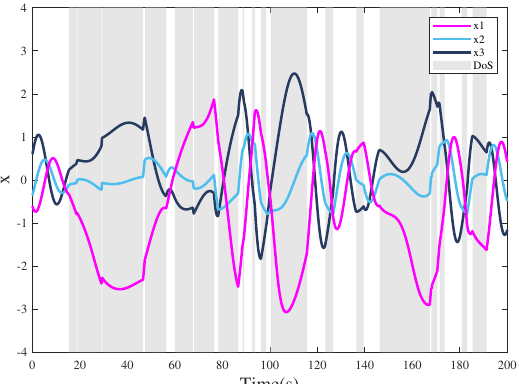
Figure 9. The state trajectories of unstable triggering control systems under aperiodic DoS attacks.